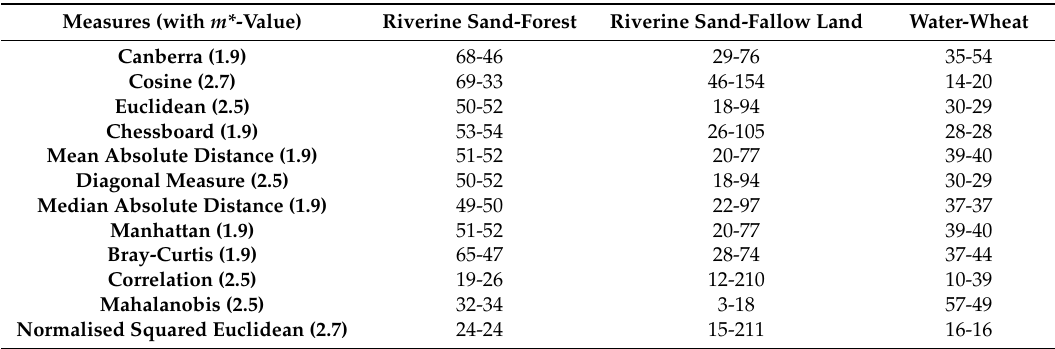
Table 3. Shows the results of all the measures while handling the mixed pixel containing two classes (membership value was calculated on 8-bit scale i.e., the target value for each class was 127.5, respectively).